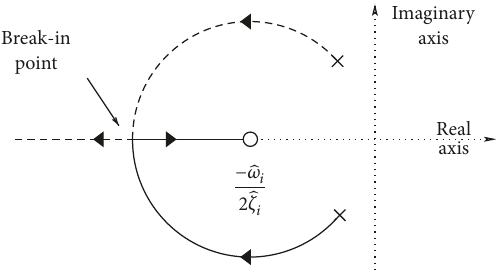
Figure 16: Root locus for the 𝑖 th characteristic equation in